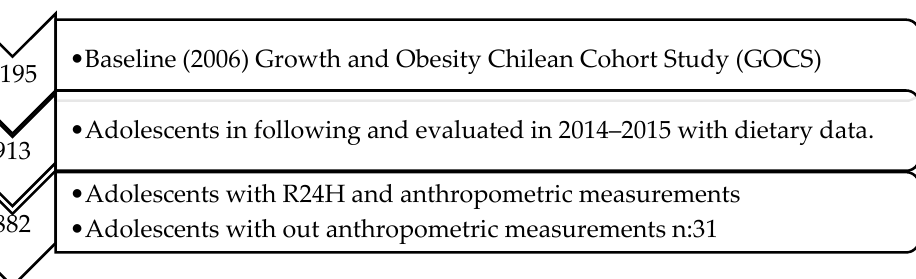
Figure 1. Flowchart for participant selection in the study.